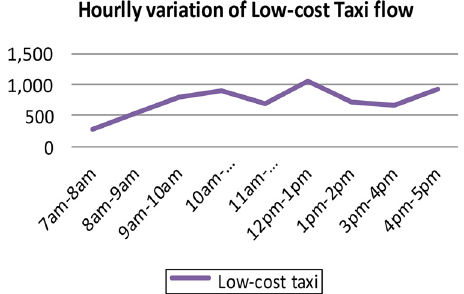
Figure 4. Average number